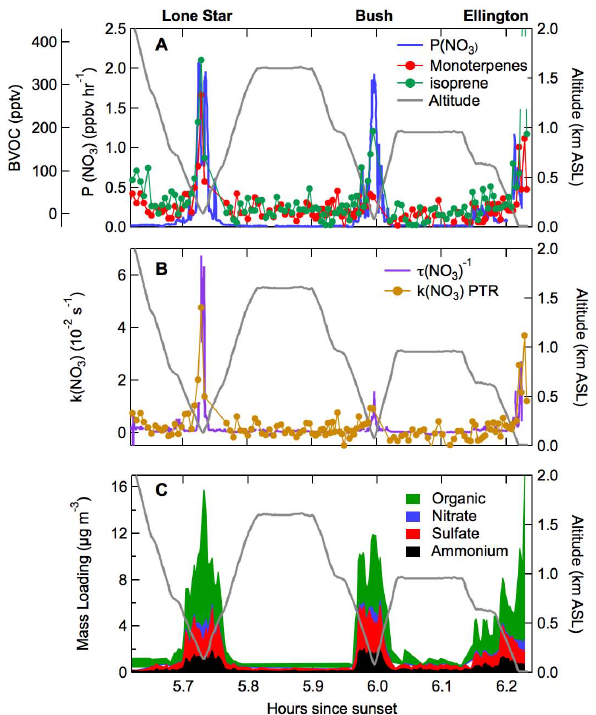
Fig. 11. Time series (plotted as hours since sunset) from five verti- cal profiles (airfields labeled at top of plot) between midnight and 01:00 local time on 12 October showing (A) nitrate radical pro- duction rate, P (NO 3 ) (left axis), monoterpene and isoprene mix- ing ratio (far left axis) and aircraft altitude (right axis); (B) inverse NO 3 lifetime, τ (NO 3 ) − 1 , and first-order NO 3 loss rate coefficient, k (NO 3 ) from PTRMS measurements of biogenic VOCs (see text), plotted together against the left axis; (C) mass loading of aerosol organic, nitrate, sulfate and ammonium from the AMS. Aircraft al- titude is plotted against the right axis for reference in (B) and (C) .